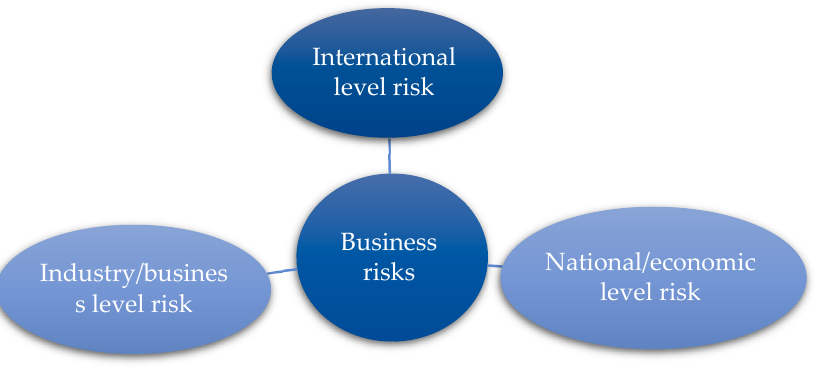
Figure 2. Business risks in the face of a crisis.